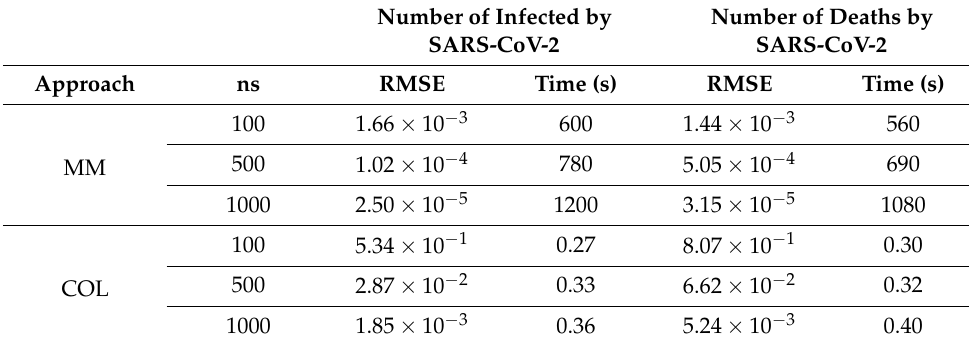
Table 9. RMSE of the state variables of SARS-CoV-2 for α i = 10